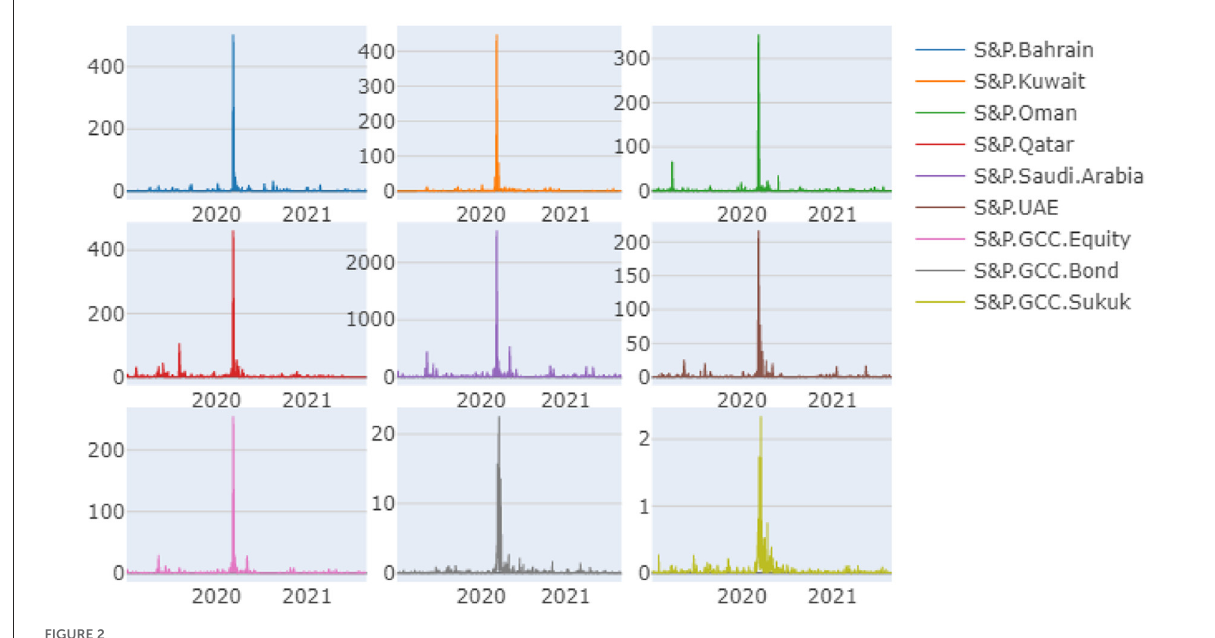
FIGURE2 The S&P equity, bond and Sukuk indices